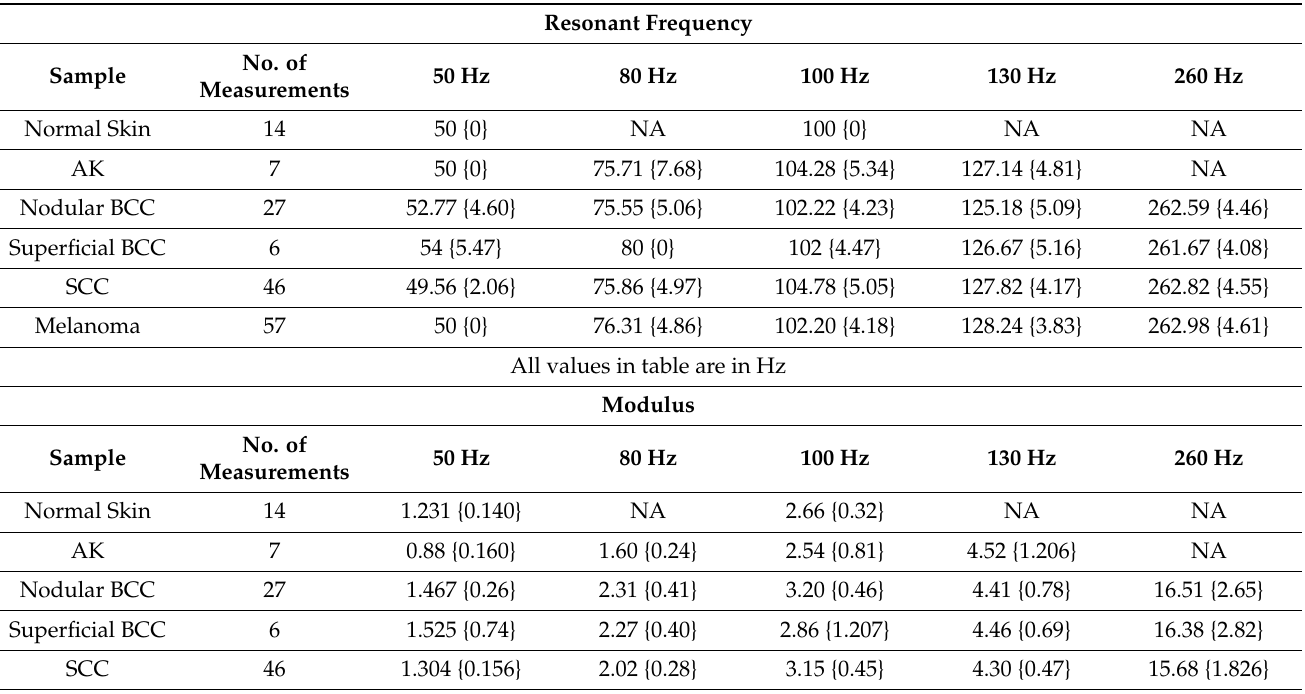
Table 1. Mean resonant frequency values (top) and standard deviations {} for the resonant frequency peaks found for normal skin, AK, nodular BCC, superficial BCC, SCC, and melanoma. Note that 2 measurements were made at 10 Hz intervals, and as result all resonant frequency peaks do not fall on the same exact